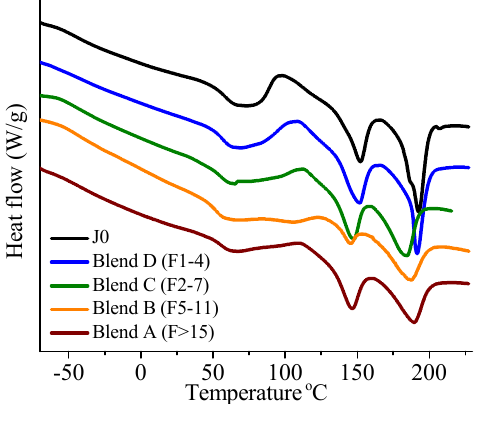
Table 6. DSC data of the